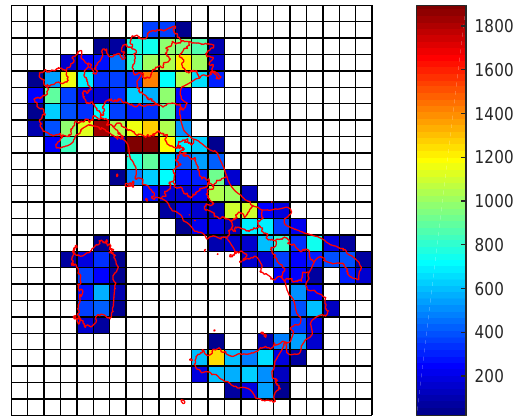
Figure 3. Total number of data per cell over a 50km grid.